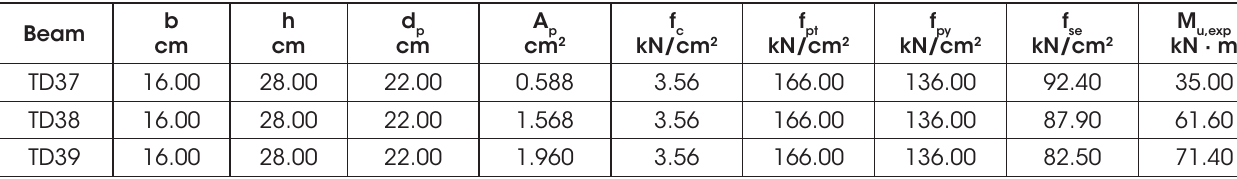
Data of the beams tested by TAO e DU [11]